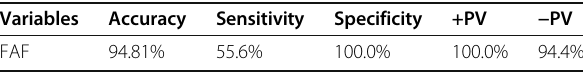
Table 4 Diagnostic accuracy of FAF in prediction of visual field